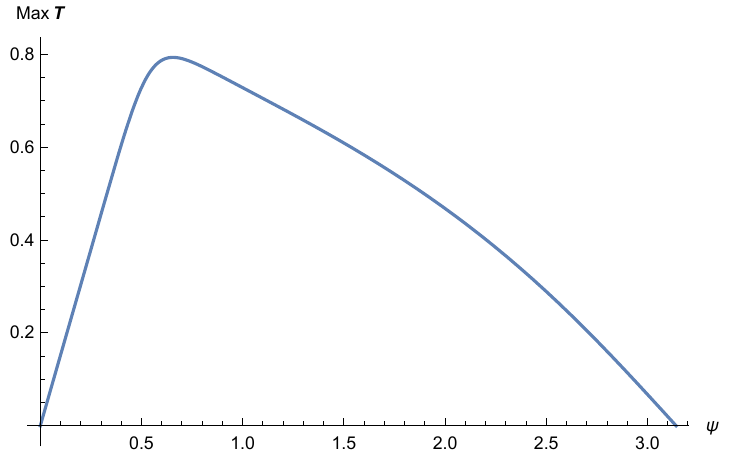
Figure 1 . A plot of the maximum possible value of the temperature T of the M2-M5 branes at each angle for p= ~ M = 0 :